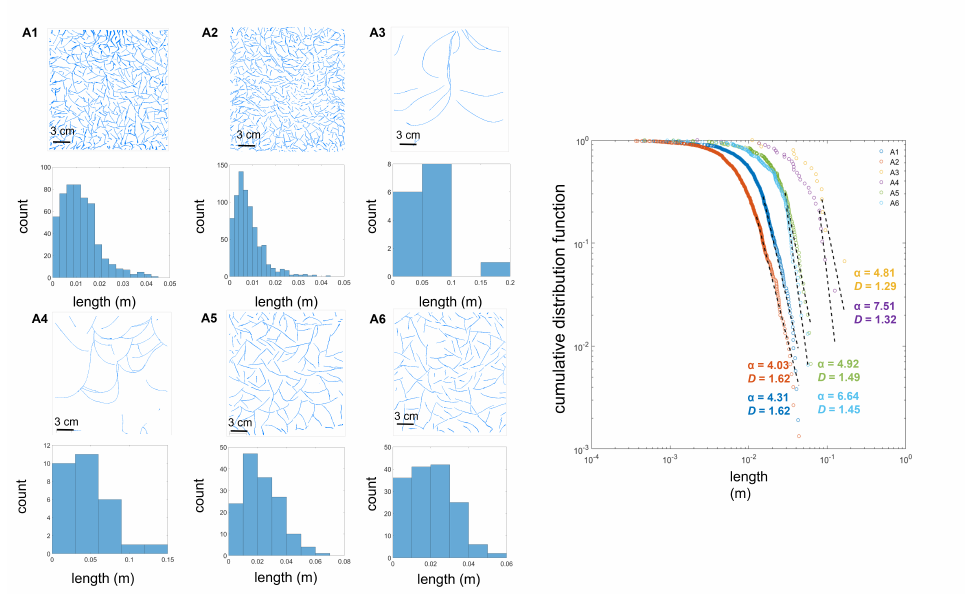
Figure 6. Segmented fracture networks and cumulative distribution function for shale rock analog images corresponding to samples A1, A2, A3, A4, A5, and